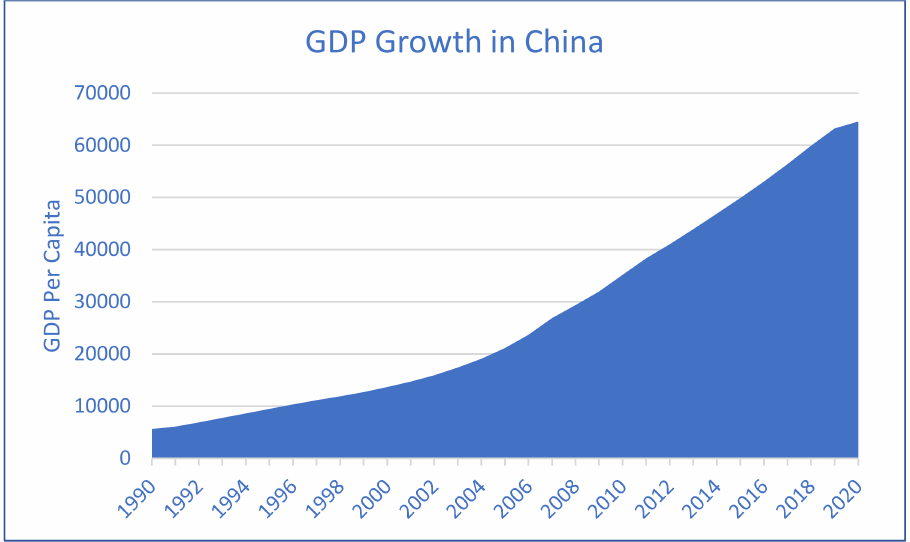
Figure 1. CO 2 Emissions in China (1990–2020).